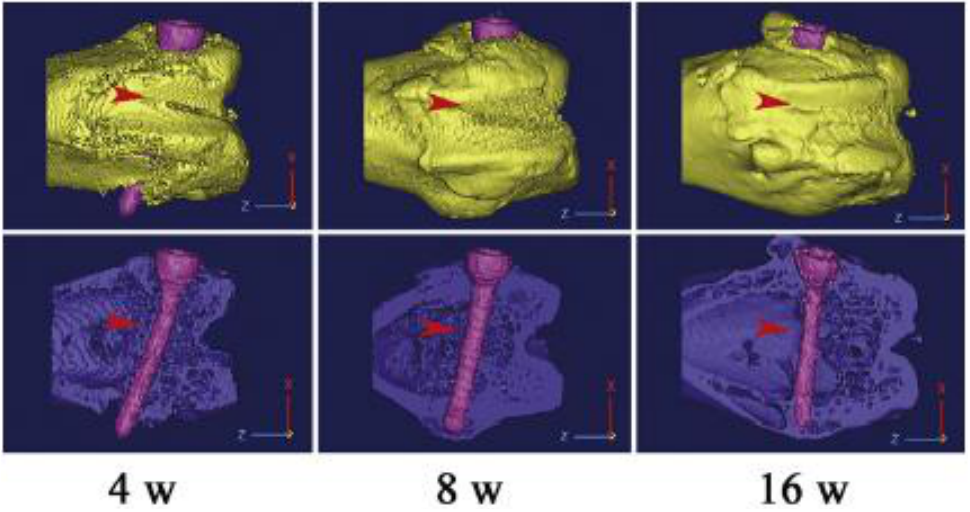
Figure 2. 3D images of the gross morphology ( upper ) and coronal sections ( lower ) of femoral intracondyle fixed by HP Mg screws at 4, 8, and 16 weeks. Red arrowheads mark the specific screw portion exposed to fracture gap [72].